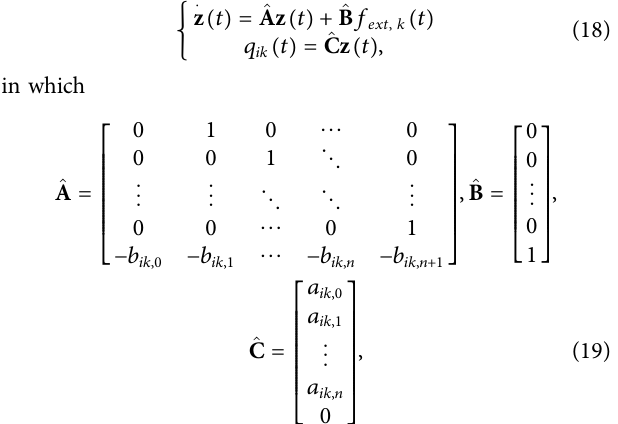
Frontiers in Energy Research |